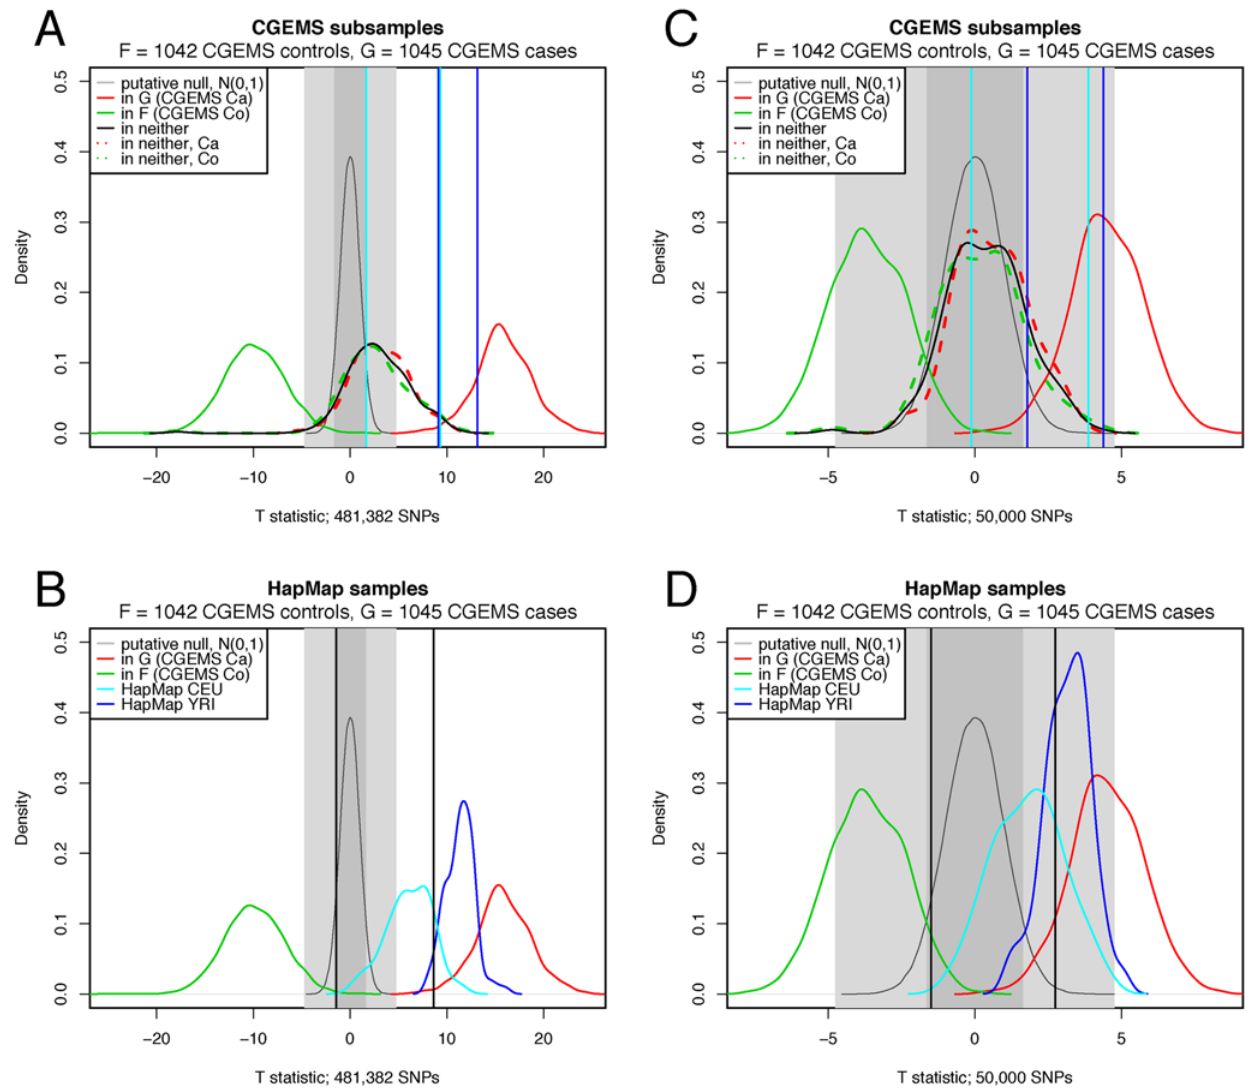
Figure 1. Comparison of T distributions. Comparison of T distributions for true positive and null samples versus putative null distribution, starting with 481,382 SNPs in (A,B) and 50,000 SNPs in (C,D). In all plots, true positive F (1042 CGEMS controls) is shown as a solid green curve, true positive G (1045 CGEMS cases) is shown as a solid red curve, and the putative null N (0,1) is given as a thin grey curve. The dark and light grey regions represent the areas for which the null hypothesis would be accepted at a ~ 0 : 05 and a ~ 10 { 6 , respectively. In plots (A,C), CGEMS test samples in neither F nor G (100 CGEMS cases and 100 CGEMS controls) are given by a heavy black curve. The CGEMS case and CGEMS control distributions within this group are shown as dashed red and green lines, respectively. In plots (B,D), T distributions are given for HapMap CEPHs (cyan) and YRIs (blue). Vertical lines mark the 0.05 and 0.95 quantiles of the negative CGEMS samples (black), HapMap CEPHs (cyan), and HapMap YRIs (blue).